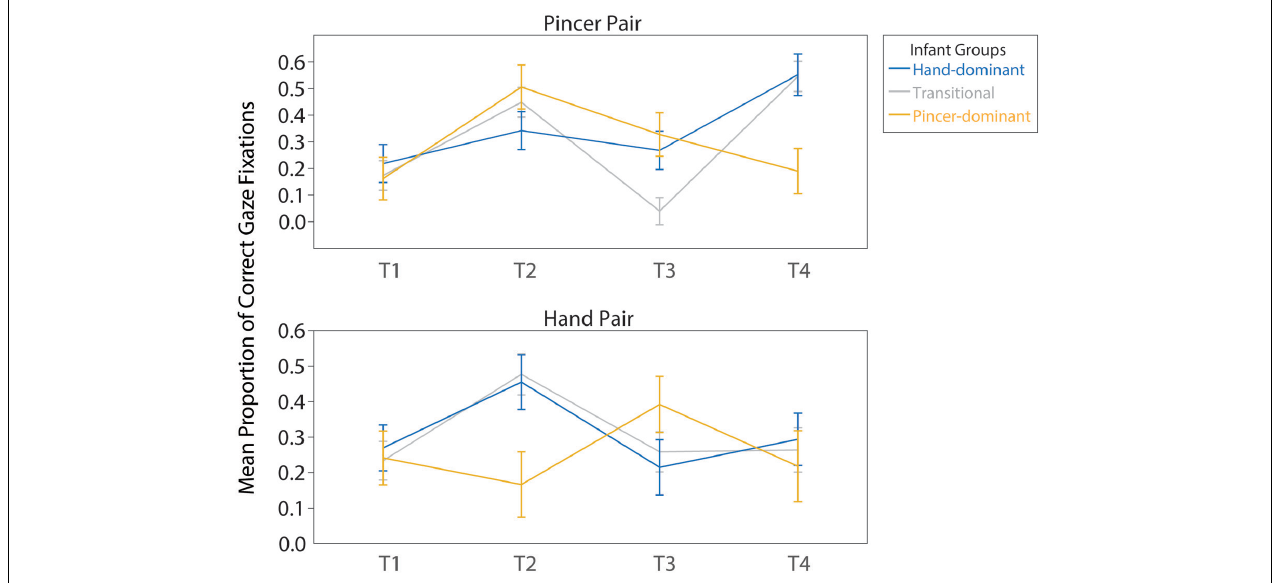
FIGURE 4 | The mean proportion of correct gaze fixations over the four time bins of the experiment plotted separately for the Pincer pair (above) and the Hand pair (below). Lines represent the three infant motor groups. Bars represent standard errors.